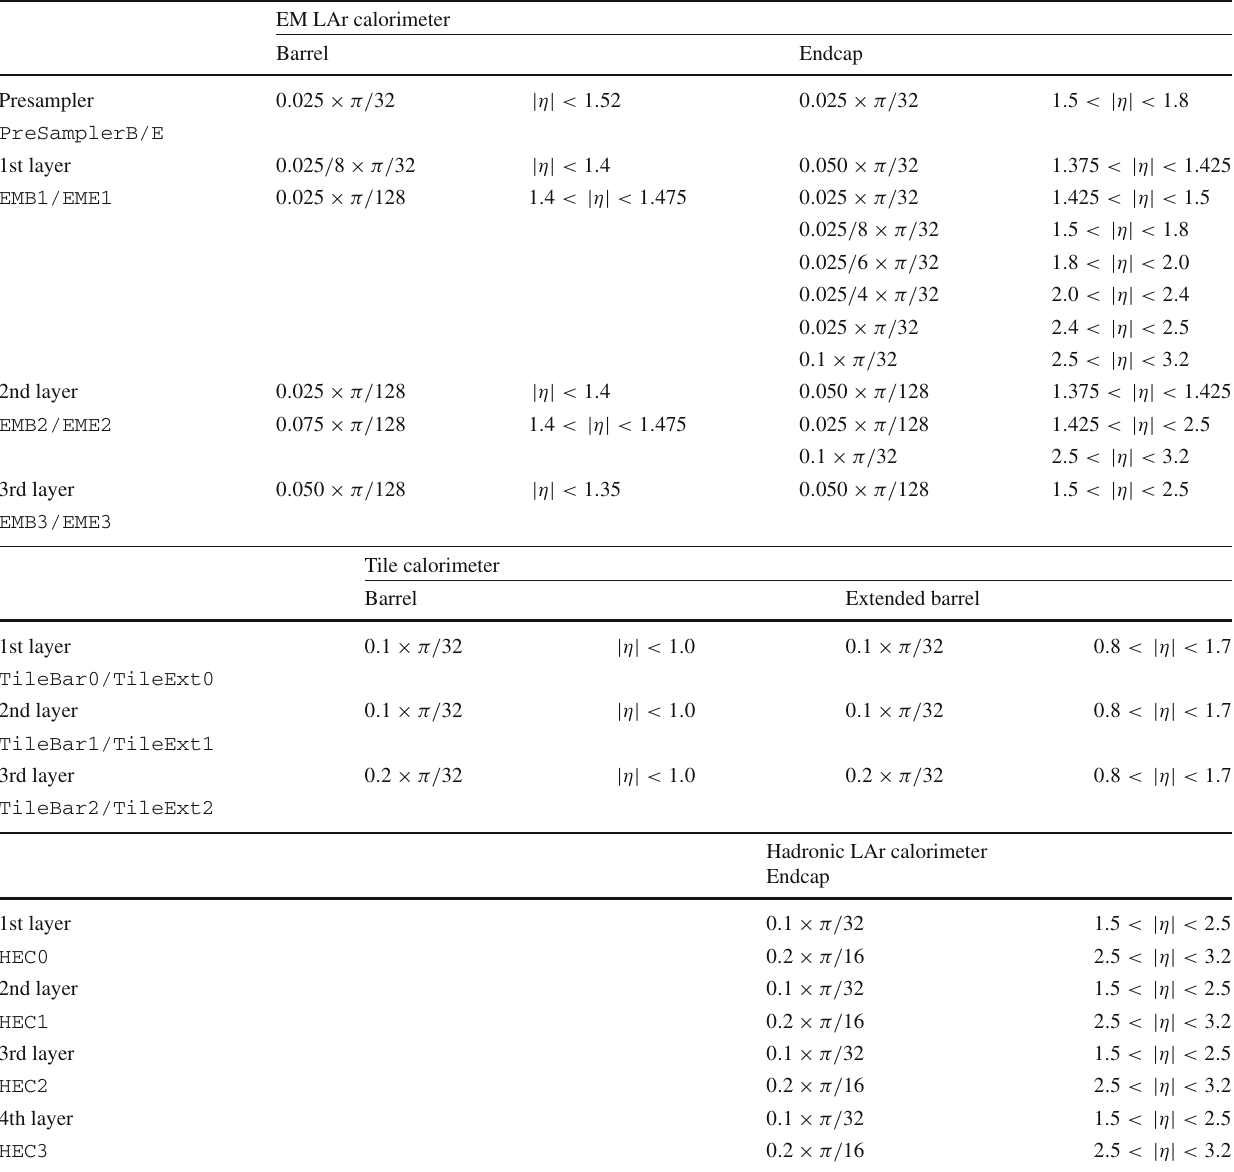
Table 1 The granularity in (cid:8)η × (cid:8)φ of all the different ATLAS calorimeter layers relevant to the tracking coverage of the inner